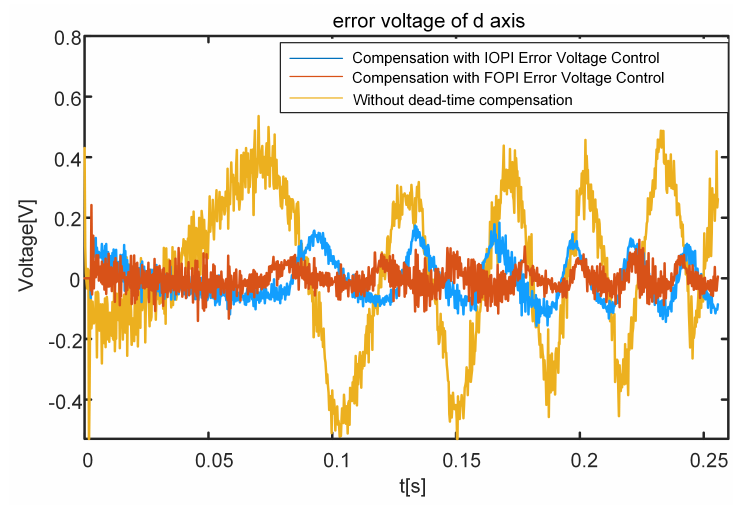
Figure 27. Comparison of the error voltage of d-axis.